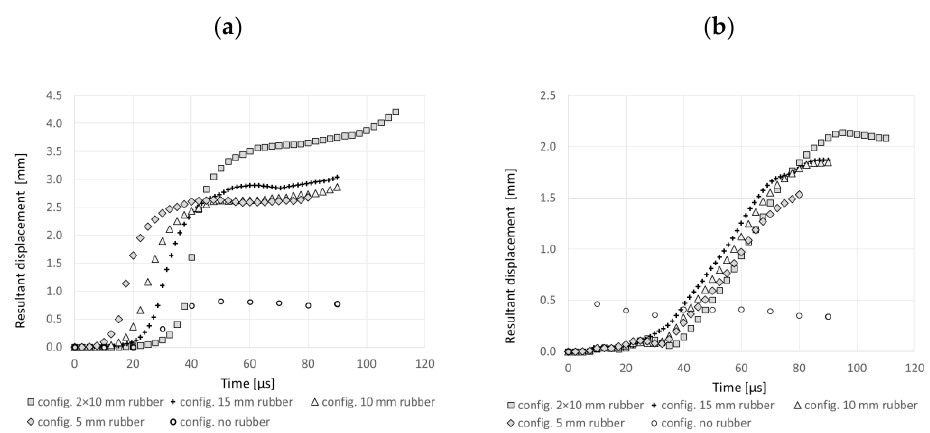
Figure 14. The resultant displacement for ( a ) point 5 (on the back plate) and ( b ) point 2 (on the front plate) in the simulation of the configurations with different rubber thicknesses. Figure 13, based on all simulated configurations with different rubber thickness (cf.